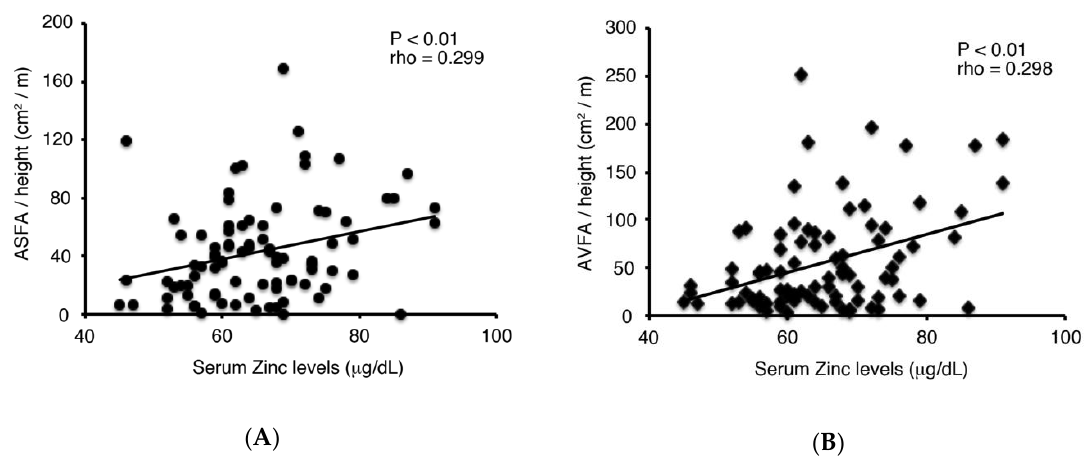
Figure 1. Correlations between serum Zinc levels and ( A ) ASFA standardized for height (ASFA/height, A) or ( B ) AVFA standardized for height (AVFA/height, B). Abbreviations: ASFA, abdominal subcutaneous fat area; AVFA, abdominal visceral fat area. Table 1. Patient characteristics.